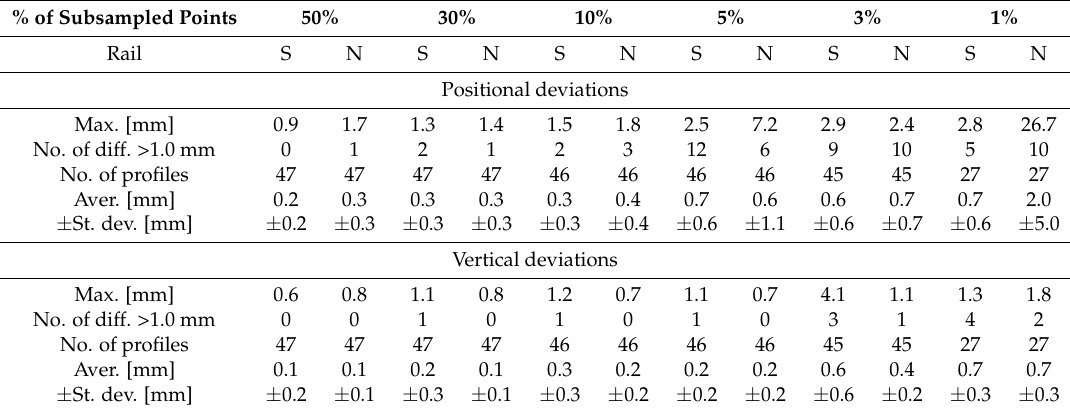
Table 4. Numeric representation of the deviation differences when removing points. % of Subsampled Points